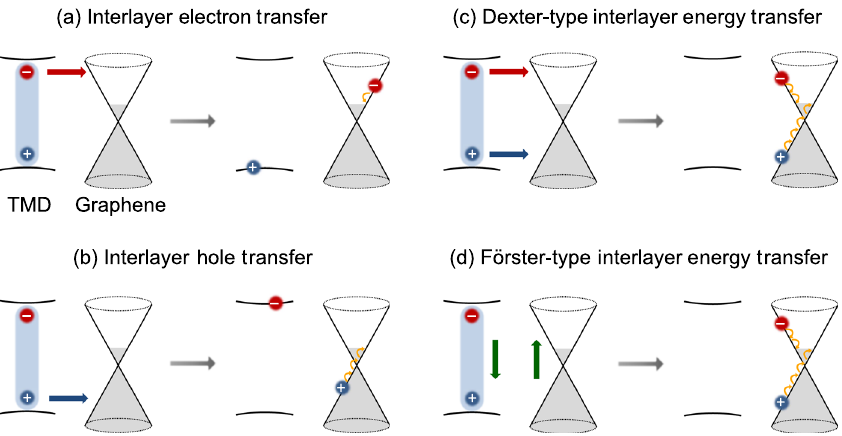
FIG. 7. Sketches, in momentum-energy space, of interlayer (a) electron and (b) hole transfer, and (c) Dexter-type and (d) Förster-type energy-transfer processes from monolayer TMD to graphene. Band-edge ( A ) excitons are shown by the blue shaded area, with the electron in red and the hole in dark blue. The curved dark yellow arrows represent ultrafast energy relaxation of transferred carriers in graphene down to the Fermi level. In the case of balanced electron and hole flows to graphene, the charge transfer processes effectively result in energy